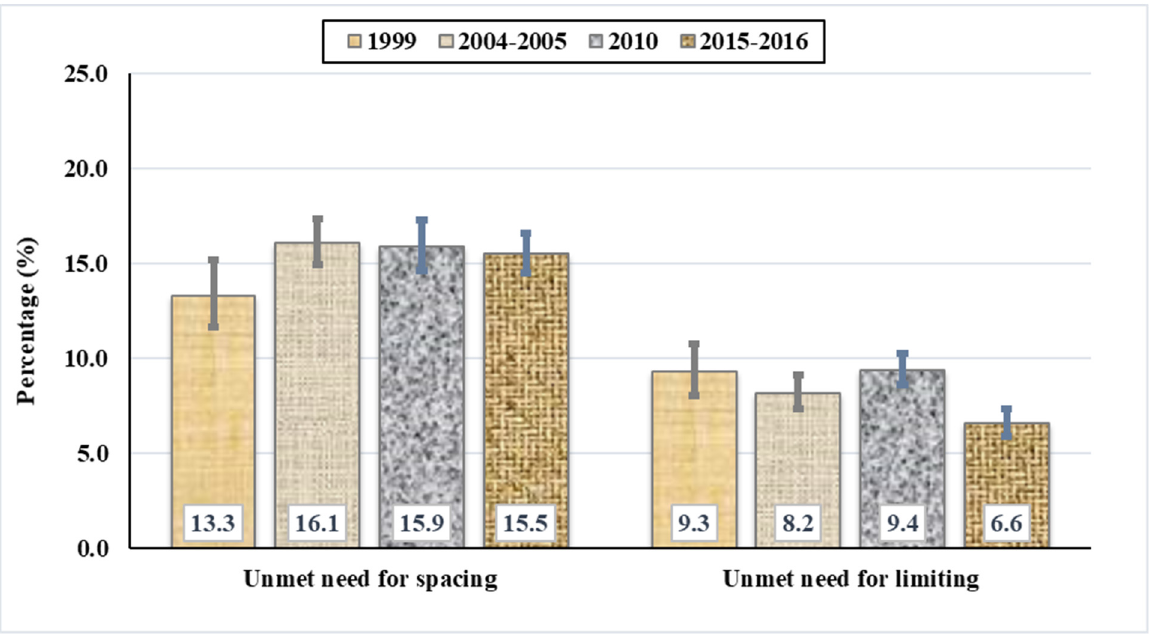
Figure 2. Trend in unmet need for family planning among married or in-union Tanzanian women, 1999 to 2016. 1999 to